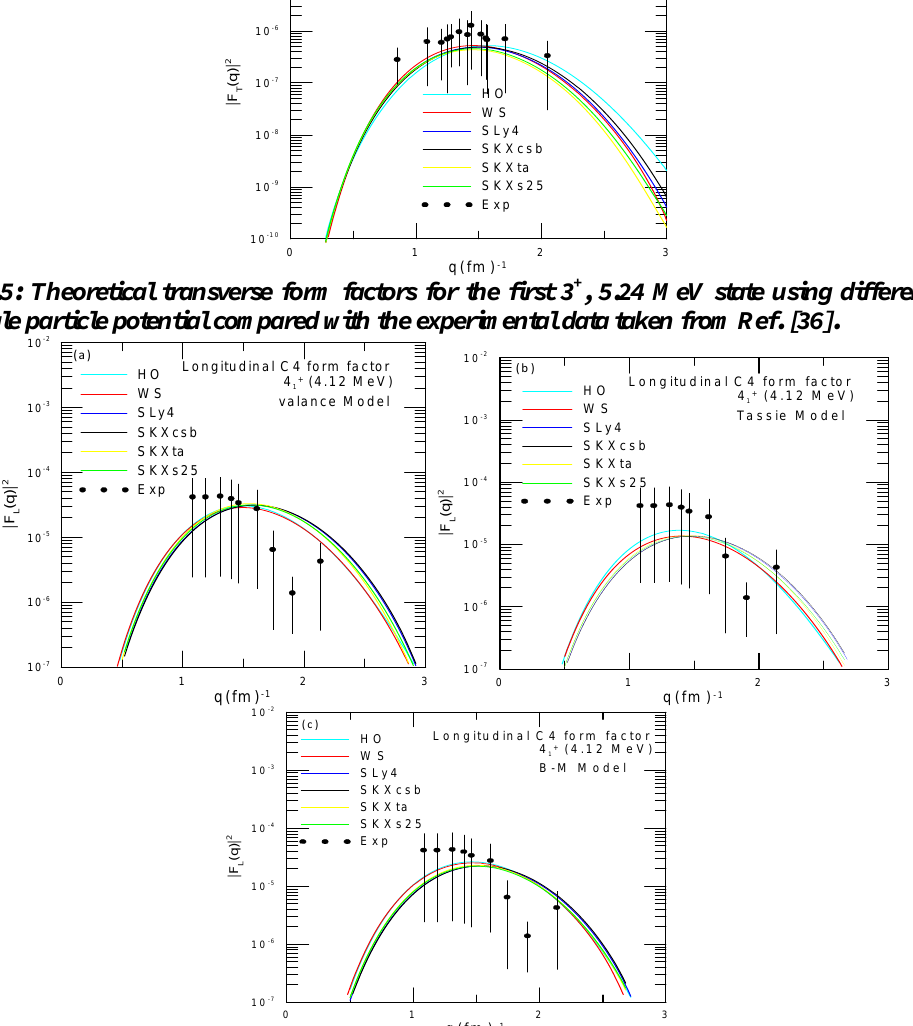
Fig.6: Theoretical longitudinal form factors for the first 4 + , 4.12 MeV state using different single particle potential compared with the experimental data taken from Ref.